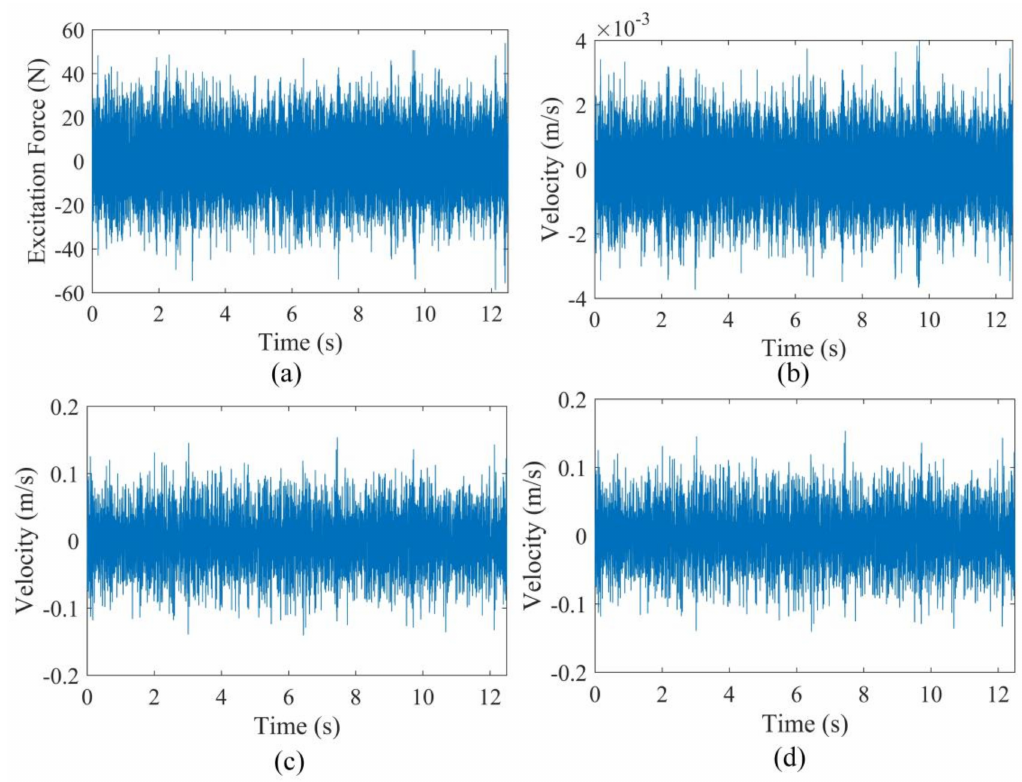
Figure 8. The acquired time domain signals of ( a ) excitation force, ( b ) measurement point 1, ( c ) measurement point 10 and ( d ) measurement point 21.